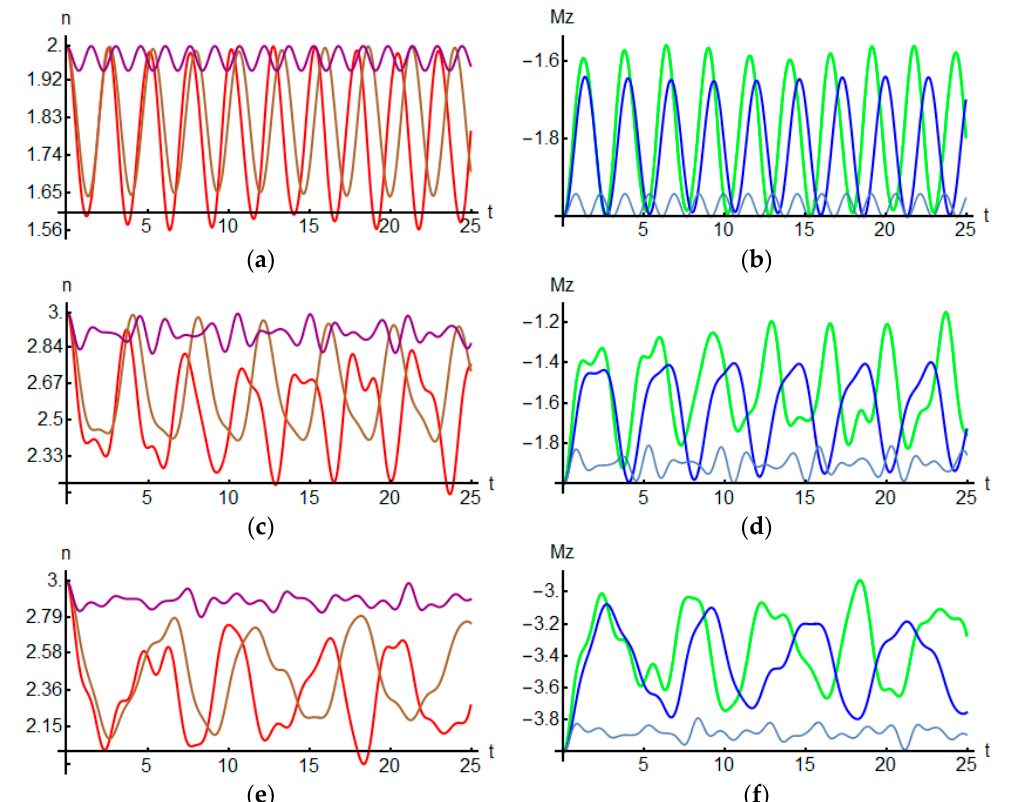
Figure 7. ( a , c , e ) show the evolution of the number of photons, n, at time t during the evolution of the system; ( b , d , f ) show the magnetic moment, Mz, along the Z axis of the system at time t during the evolution of the system. The red line corresponds to the number of photons and the green to the magnetic moment in the case of single-photon and two-photon absorption simultaneously. The purple and teal lines correspond to the case where there is only two-photon absorption. The brown and blue lines correspond to the case where there is only a one photon absorption. The first two ( a , b ) correspond to an initial state |2, ↓↓⟩ , the next two ( c , d ) to an initial state |3,↓↓⟩ . The remaining two correspond to an initial state |3,↓↓↓↓⟩ .